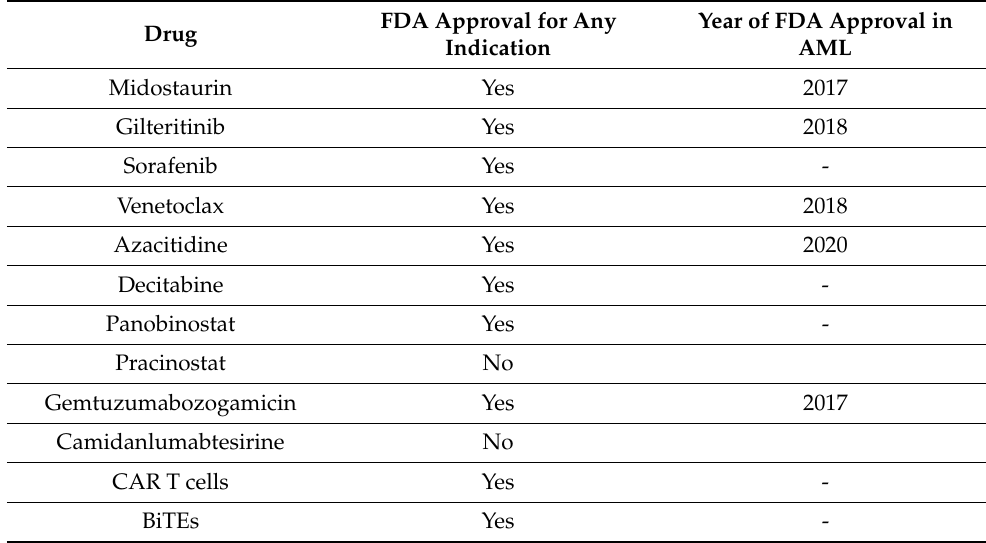
Table A1. Food and Drug Administration (FDA) approval status of novel therapies for AML.